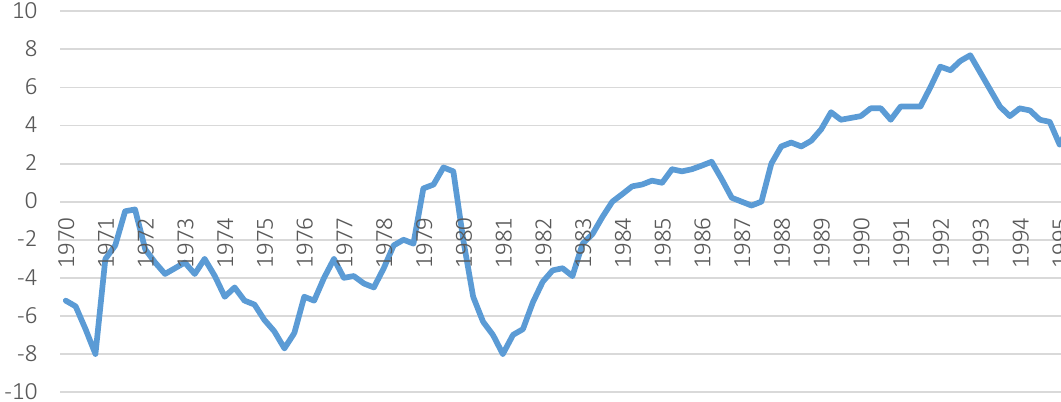
Figure 7. Norwegian real interest rates after tax, 1970–1995